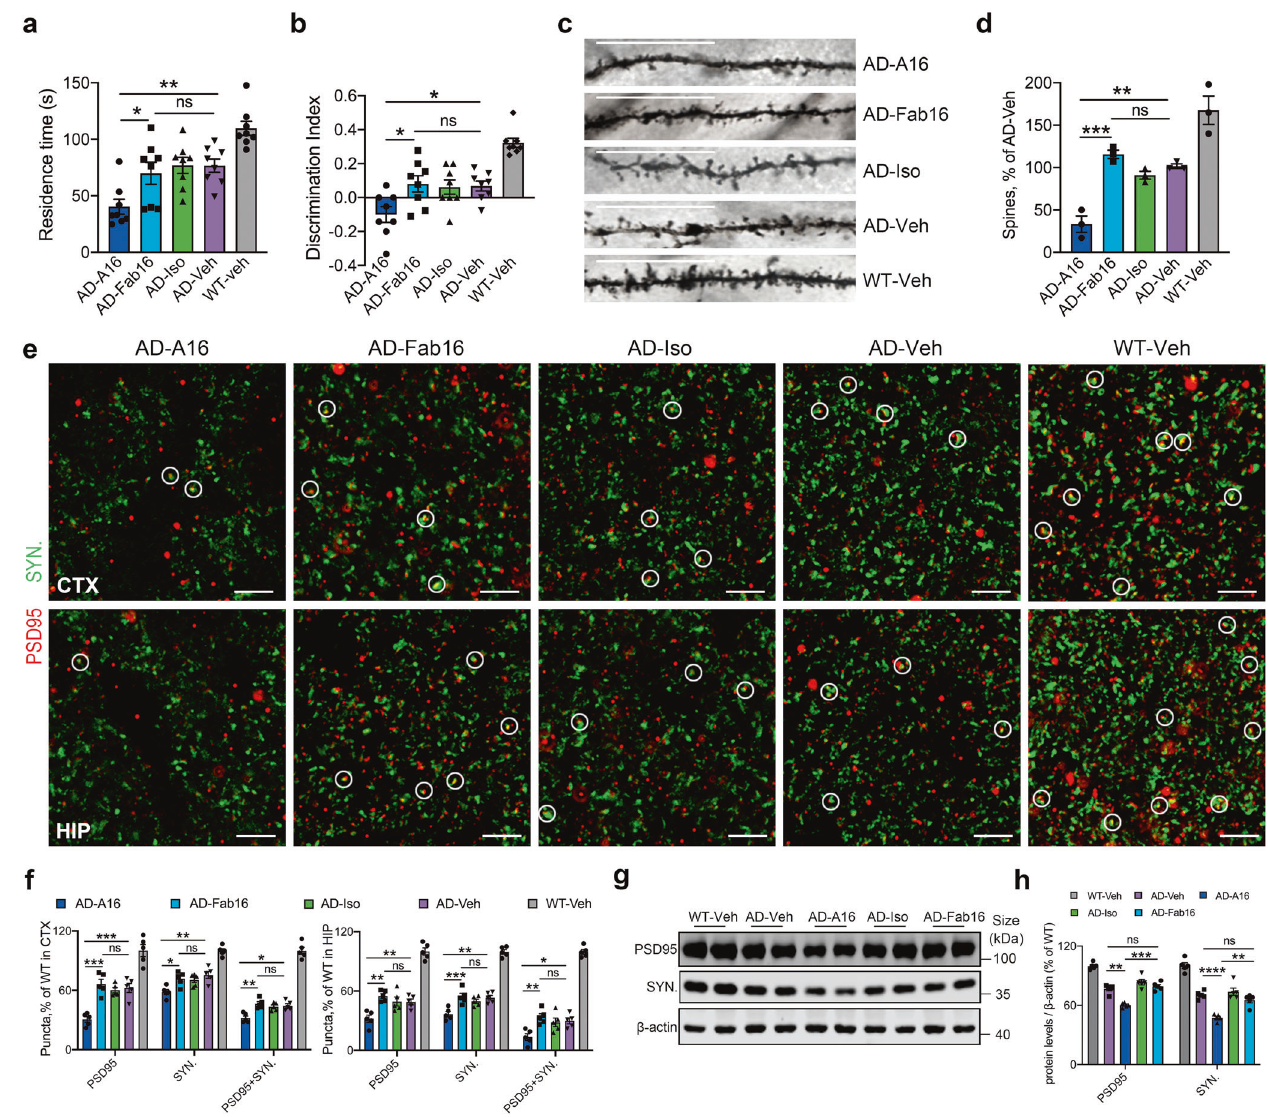
Fig. 1 Full effector antibody A16 robustly mediates synapse loss and cognitive de fi cits in APP/PS1 mice at 24-48 h post-treatment. a The time spent by APP/PS1 or WT mice in the novel arm of Y-maze at 24 h post-treatment with A16, Fab16, isotype control antibody, or PBS ( n = 8 mice). b Discrimination index of the mice in novel object recognition test ( n = 8 mice). c Representative images of Golgi-stained dendrites from the cortical neurons of APP/PS1 or WT mice treated with A16, Fab16, isotype control antibody, or PBS, at 48 h post-injection. Scale bar, 50 μ m. d Quanti fi cation of dendritic spine density in c ( n = 3 mice). e Immunolabeling of PSD95 (red) and synaptophysin (green) in the cortex and hippocampus of APP/PS1 or WT mice treated with A16, Fab16, isotype control antibody, or PBS, at 48 h post-injection. White